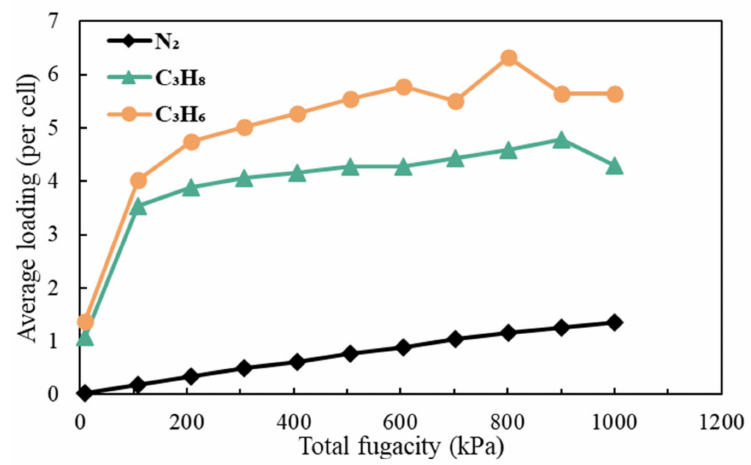
Figure 7. Adsorption isotherms of different gases on the PDMS membrane at 298 K.